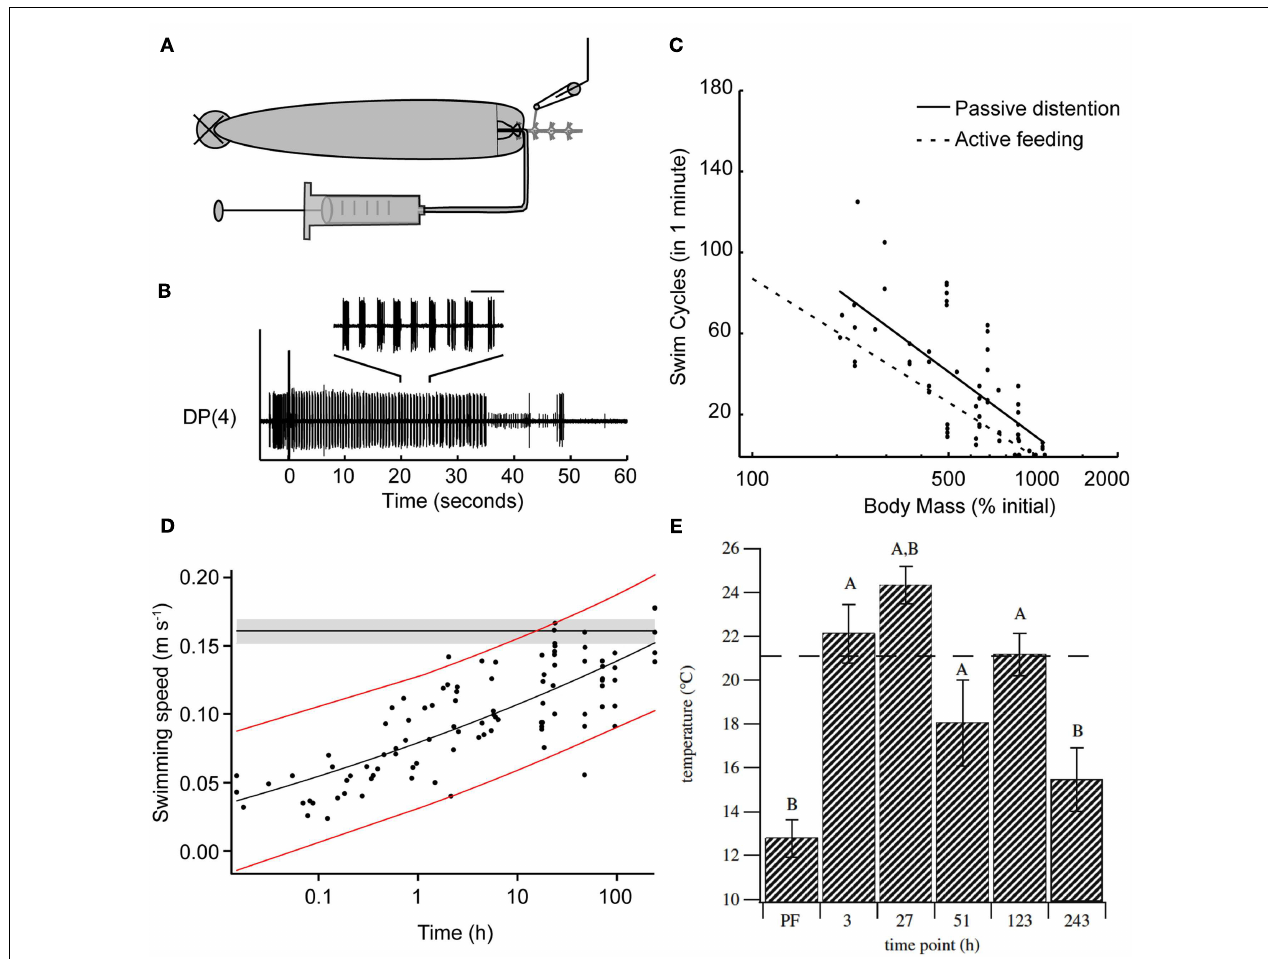
linear regression for these data points.The dashed gray line shows best fit derived from intact active feeding preparations. [ (A–C) from Gaudry and Kristan, 2010.] (D) Swimming speed measured following a bout of feeding. Leeches were fed and then stimulated to swim.The speed of each swim episode was calculated and leeches were tested for up to 10days following feeding. Red lines represent the 95% confidence interval for post-feeding data.The horizontal black line and gray shaded area show the mean pre-feeding values and 95% confidence interval of the mean. (Modified from Claflin et al., 2009.) (E) Preferred temperature of leeches before and up to 10days following feeding. Leeches were acclimated to 21˚C, fed, and then tested on subsequent days.The dashed line indicates the acclimation temperature ( T a ). (A) is significantly different from the pre-feeding (PF) preferred temperature (ANCOVA, planned contrasts, Dunnett’s procedure, p < 0.05; n = 7 for PF, 3, 27 and 51h, n = 6 for 123 and 243h); (B) is significantly different from T a (one-sample, two-tailed, t -test, p < 0.05 after applying Dunnett’s correction). Error bars indicate 1SEM. (Data from Petersen et al.,